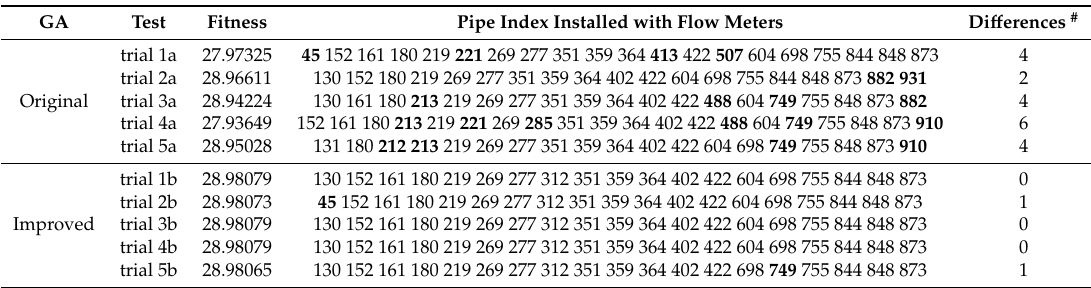
Table 5. Performance comparison of 10 trials ( OF3 ).